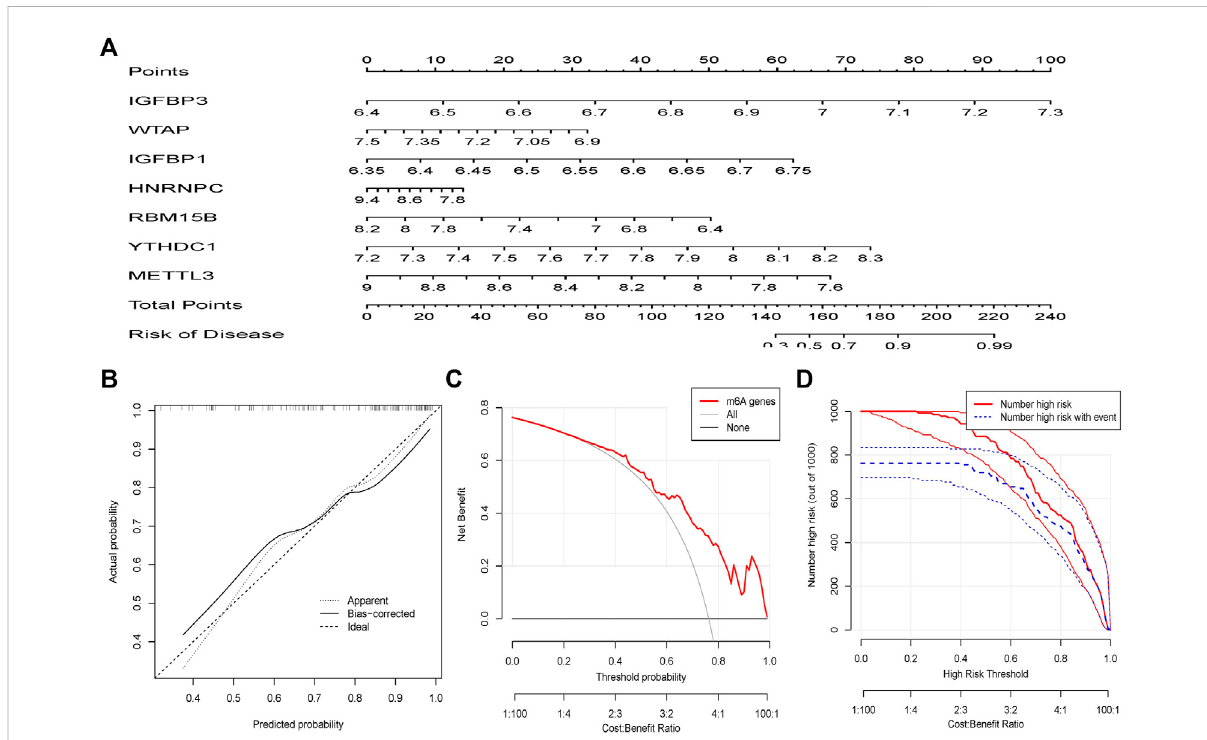
FIGURE 5 The nomogram model is created. (A) The nomogram model was built using the m 6 A regulators of the seven candidates. (B) The calibration curve reveals the nomogram model's predictive capacity. The calibration curve reveals the nomogram model ’ s predictive capacity. (C) Patients with OA may bene fi t from relying on the nomogram model. (D) The clinical relevance curve is used to analyze the nomogram model ’ s clinical